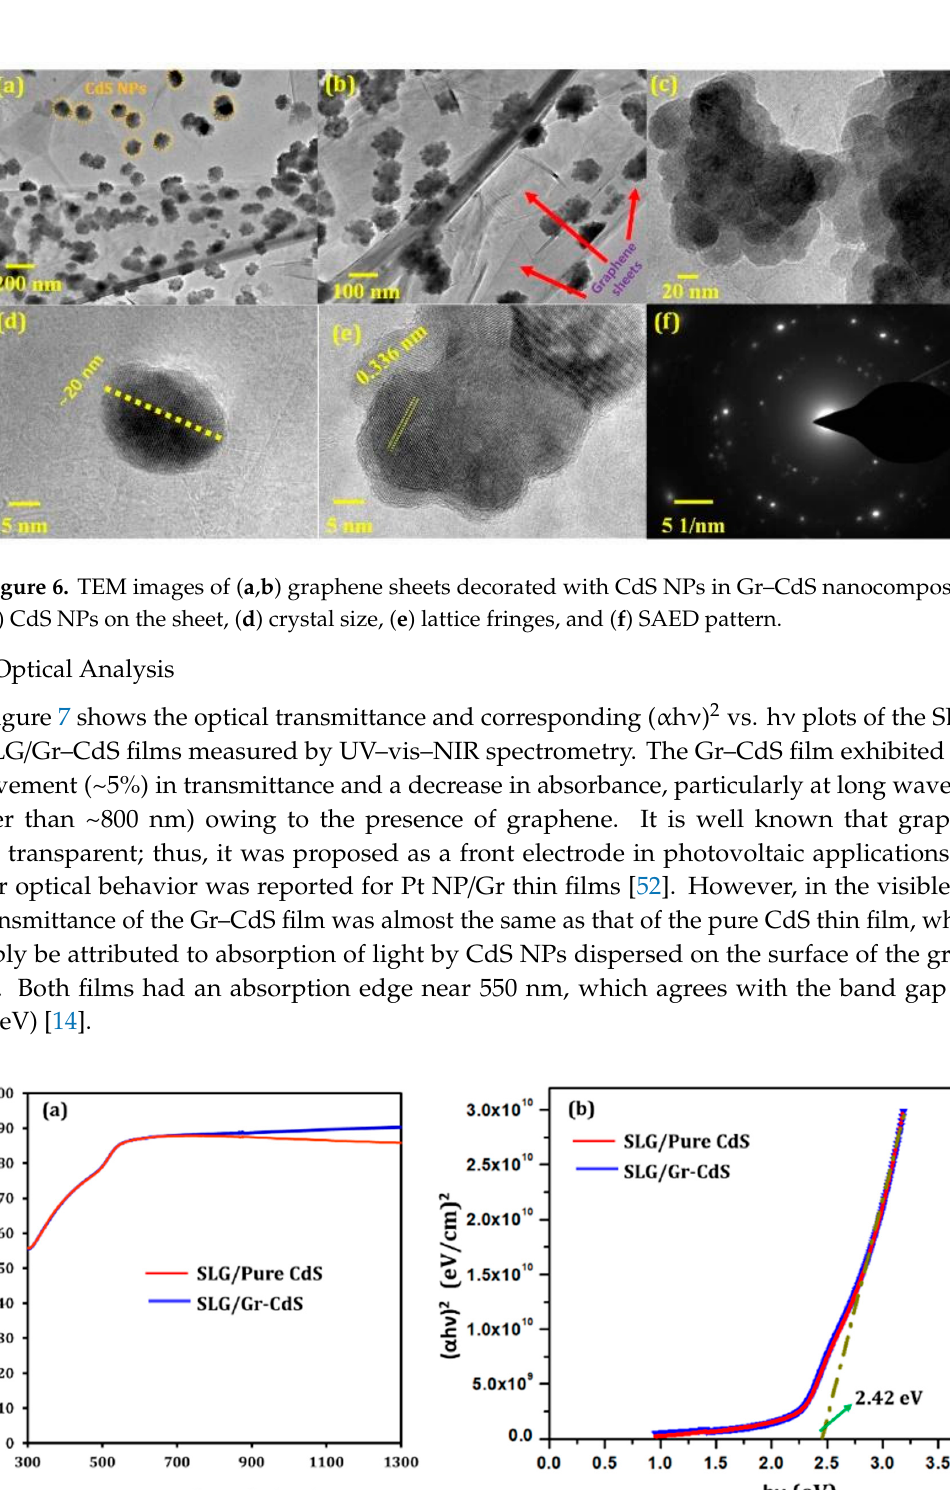
Figure 7. (a) Transmittance spectra and (b) ( α h ν ) 2 vs. h ν plot of SLG/CdS and SLG/Gr–CdS thin films.